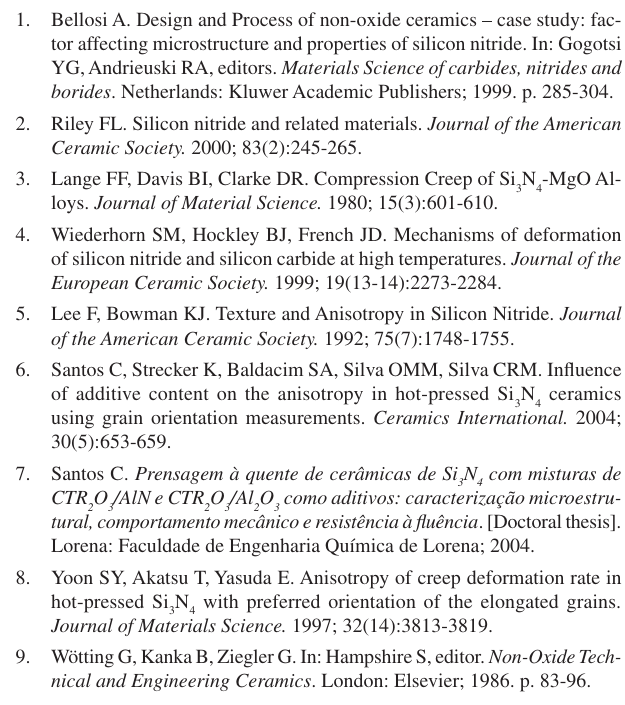
(°) Microstructural Aspects P Possibles Before After Before After crystalline Grain size Aspect Grain Size Aspect intergranular Average Ratio Average phases ( µ m) ( µ m)